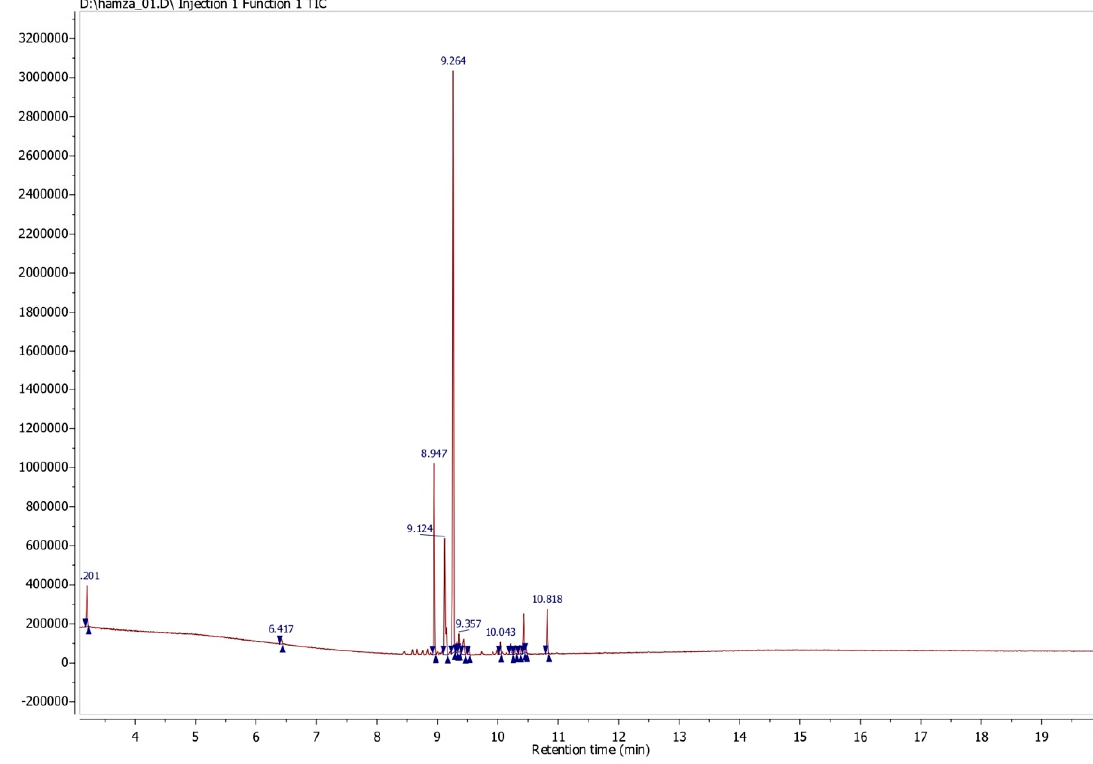
Table 1. Cedarwood phytochemical components.